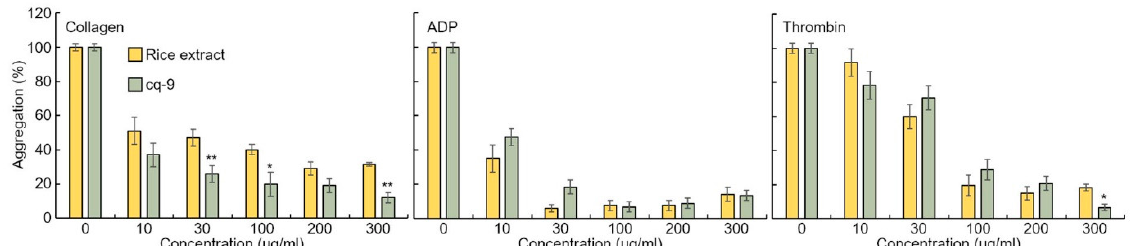
Figure 7. Rice extract or cq-9 inhibits agonist-induced rat platelet aggregation. Collagen-, ADP-, or thrombin-stimulated washed platelets pre-treated with Rice extract or cq-9 extract concentrations in the presence of 1 mM CaCl 2 . Platelet aggregation is expressed as the percentage of the maximal platelet aggregation by Collagen (0.625 µg/mL), ADP (5 µM), or thrombin (0.8 Unit). * p < 0.05, ** p < 0.01 Rice extract or cq-9. Data are expressed as the mean ± SE (n = 4).